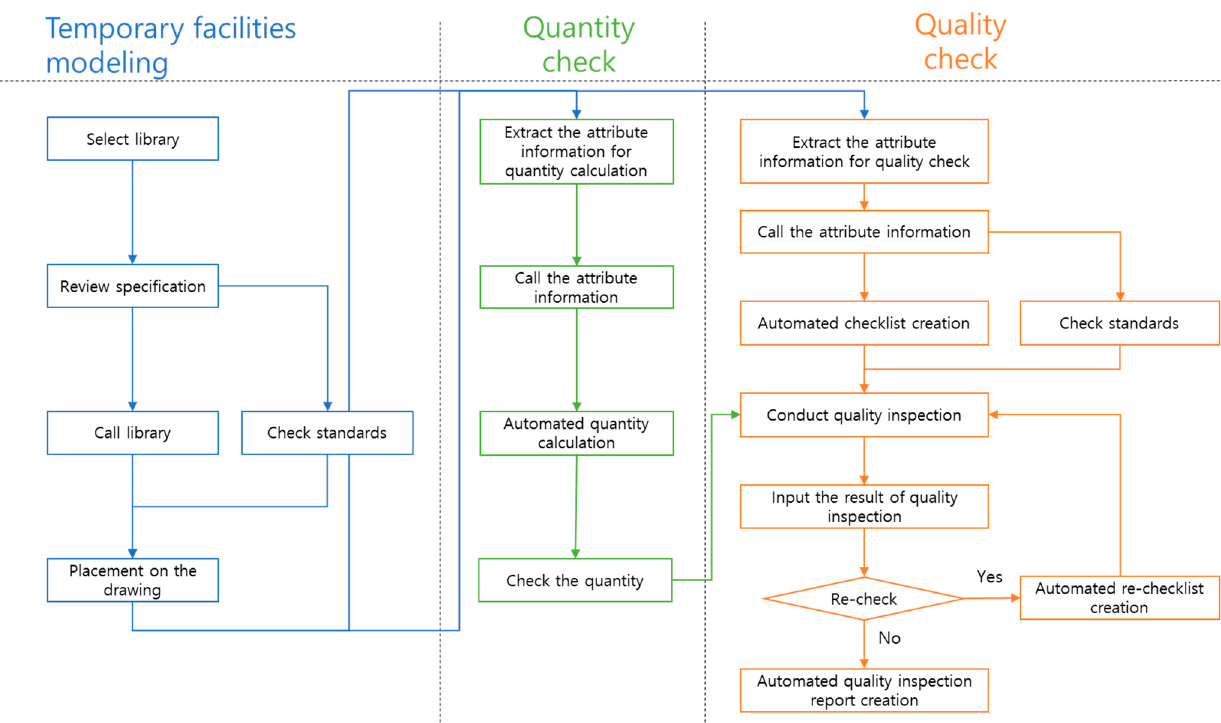
Figure 3. System prototype logic diagram.